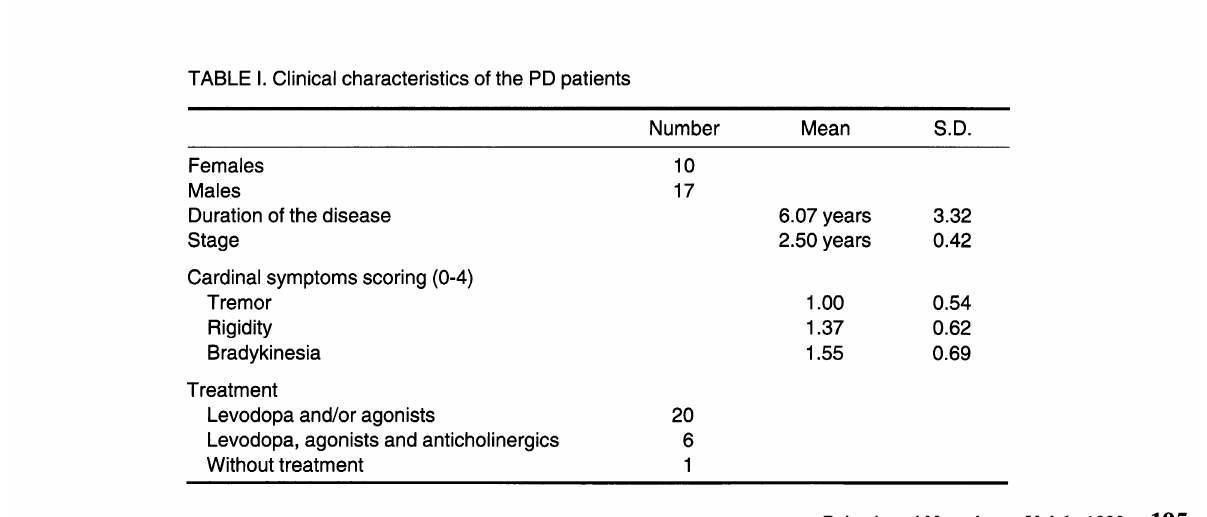
TABLE I. Clinical characteristics of the PO